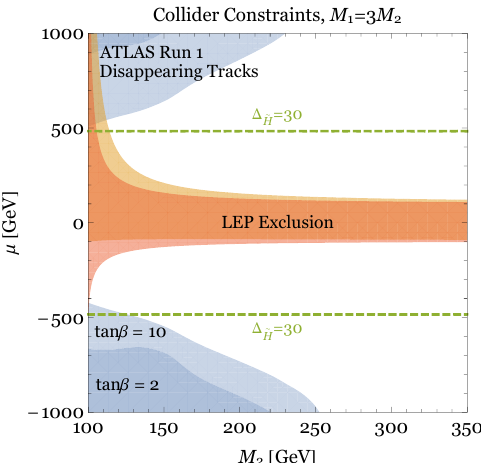
Figure 14 . Constraints on chargino parameter space from collider searches. We take M 1 = 3 M 2 , as in anomaly mediation, so that the LSP is either mostly wino-like or mostly higgsino-like. Highly wino-like LSPs are constrained by the ATLAS and CMS searches for disappearing tracks (left-hand corners of the plot), while points with charginos lighter than about 100 GeV are constrained by LEP (band in the center of the plot). The dashed green line is the higgsino mass at which the tree level tuning for electroweak symmetry breaking is a factor of